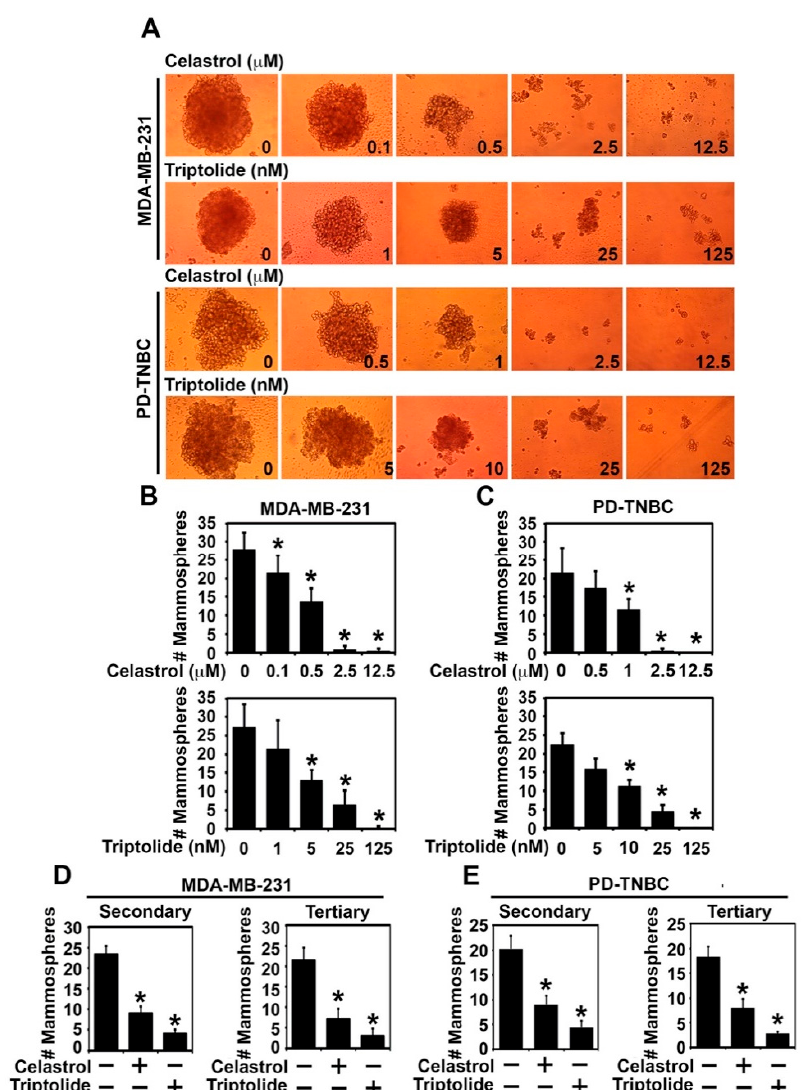
Figure 1. Celastrol and triptolide reduce mammosphere growth and number in TNBC cells. A and B) MDA-MB-231 and PD-TNBC cells were treated with celastrol (0–12.5 μ M) and triptolide (0–125 nM). ( A ) Representative images show reduction in mammosphere size. ( B , C ) Total number (#) of primary mammospheres was reduced in a dose-dependent manner following celastrol and triptolide treatment when compare to control. * p < 0.05 when compared with control. ( D , E ) Primary mammospheres of MDA-MB-231, PD-TNBC cells treated with celastrol (0.5 µ M) and triptolide (5 nM) were first treated with celastrol (1 µ m) and triptolide (10 nm), and subsequently used to grow secondary and tertiary mammospheres without drug treatment. * p < 0.05 when compared with